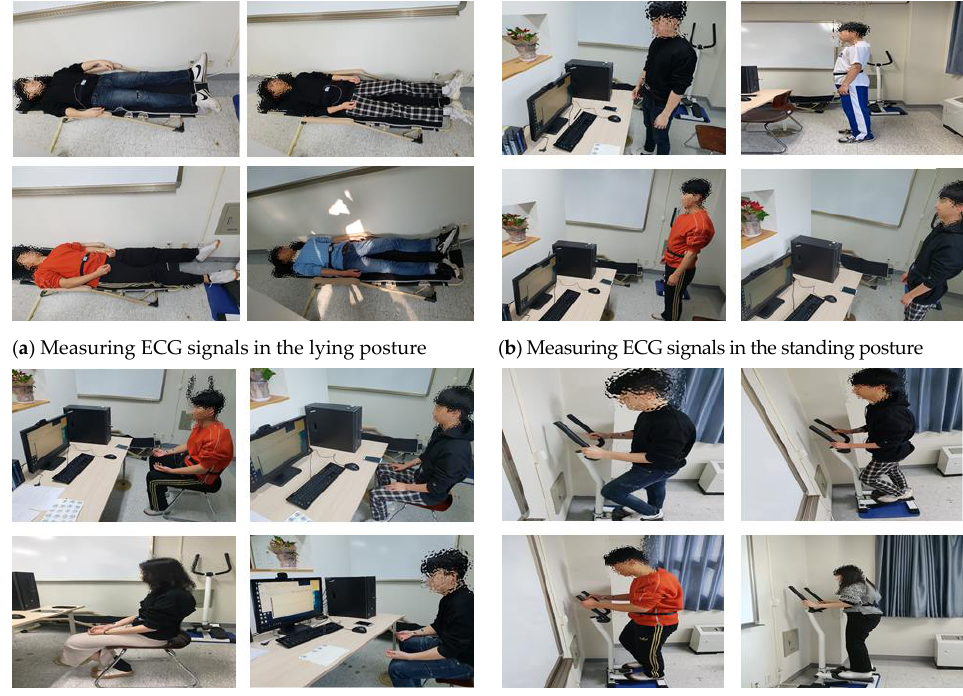
Figure 7. Definition of user states for changing ECG signals.